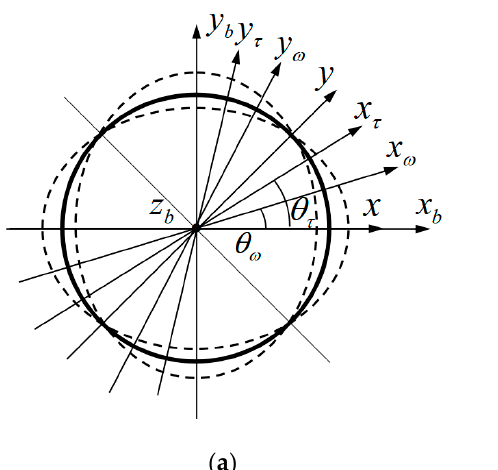
( b ) Figure 5. Mechanical model: ( a ) Mechanical model of unideal hemispherical shell resonator; and, ( b ) Equivalent mechanical model of unideal hemispherical shell resonator. When the damping forces are omitted, the motion equations of hemispherical shell resonator in